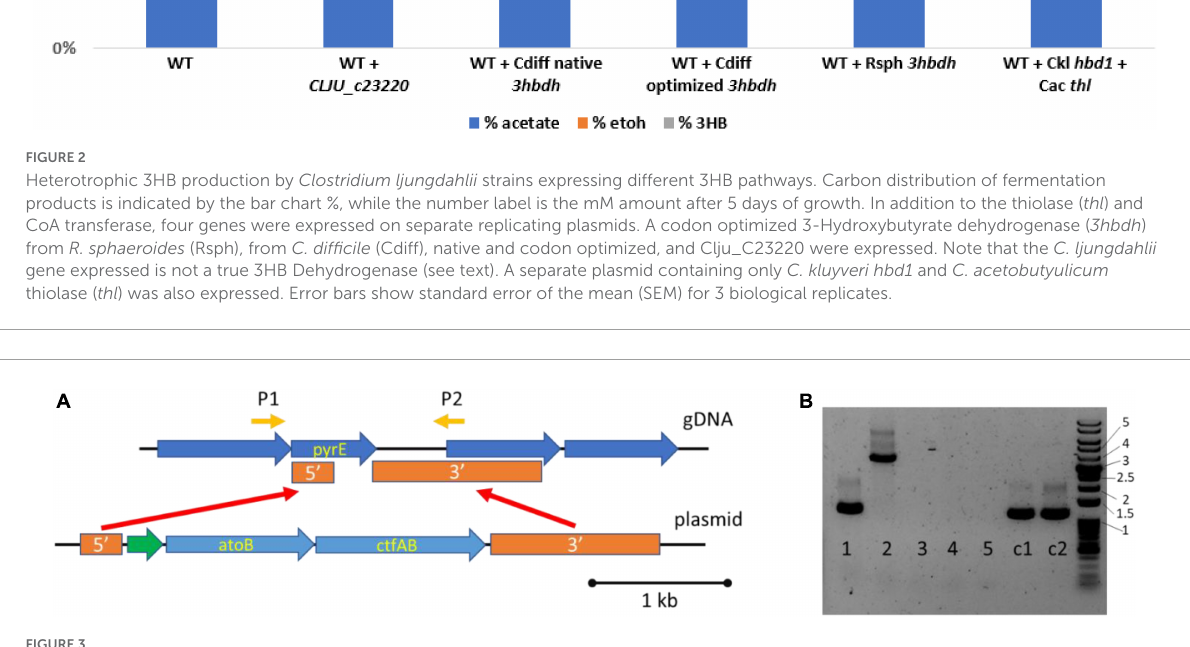
FIGURE3 Integration of atoB and ctfAB into the pyrE locus of Clostridium ljungdahlii to generate the “integrated 3HB strain.” (A) Genome integration of atoB and ctfAB into pyrE locus, driven by P fdx in green. P1 & P2 are primer binding sites for screening genomic pyrE locus. (B) PCR confirmation of integrated atoB and ctfAB using primers P1/P2 to amplify genomic locus. Lanes 1–5 contain screened 5FOA colonies, C1 and C2 are control gDNA from wild type DNA. A successful integration generates a size of 3.8 kb (Lane 2), whereas the wild type size is 1.2 kb (Lane 1, C1, and C2). The numbers next to the DNA ladder indicate kb